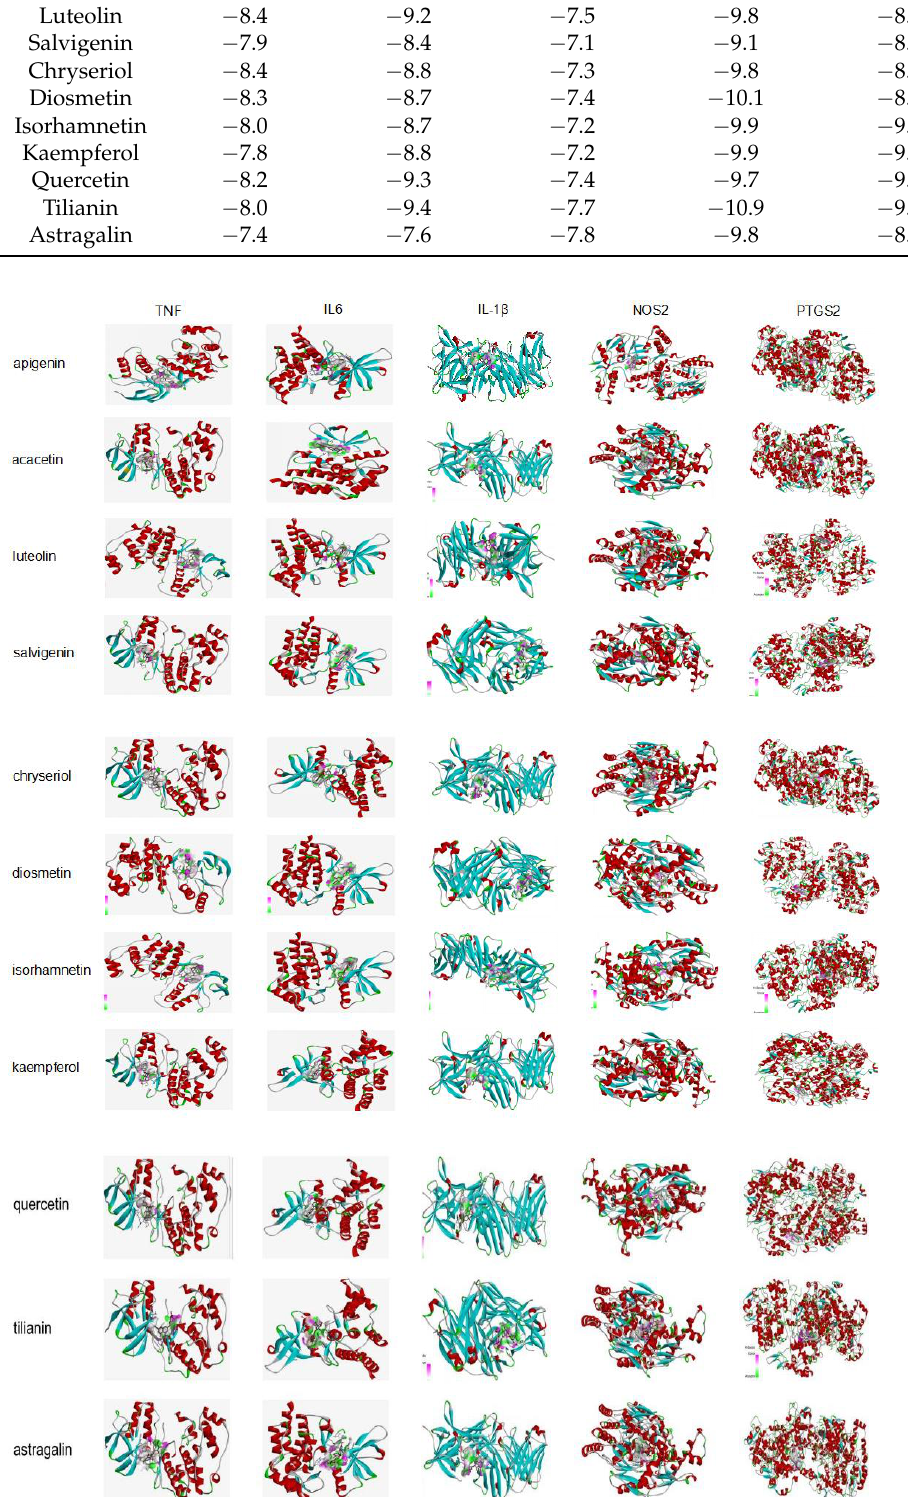
Figure 6. Molecular docking of compounds with top